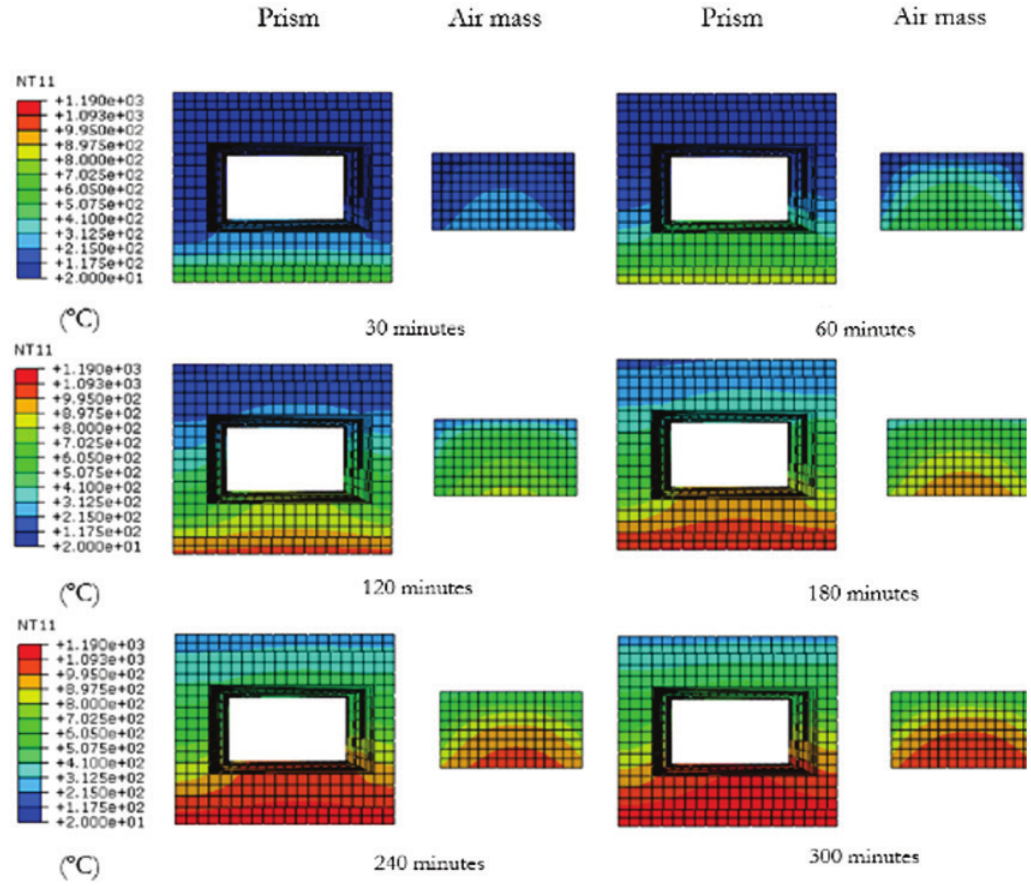
Thermal fields developed in the coated prism on both faces and in air